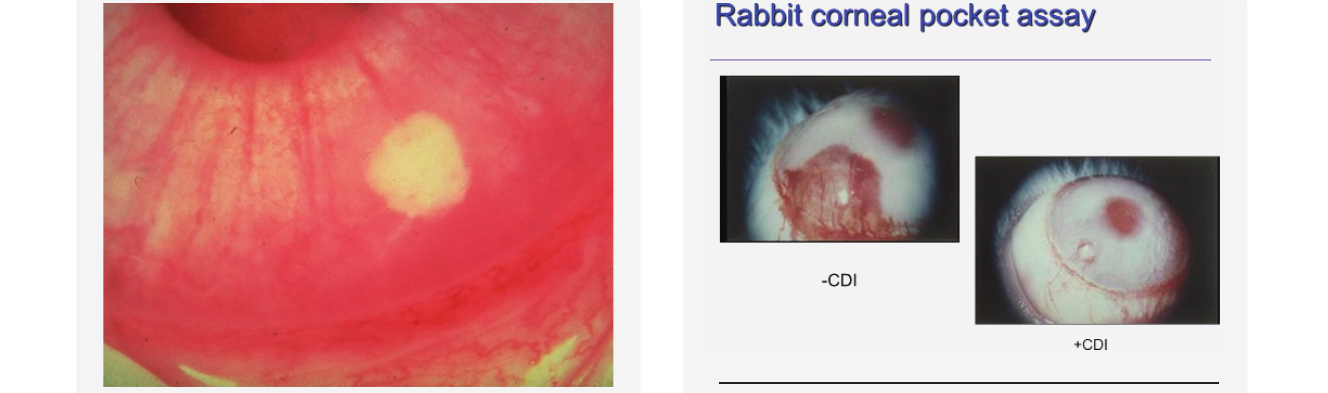
Figure 4. Rabbit Cornea with and without Polymer Pellets Containing Cartilage Derived Inhibitor (CDI) at Week